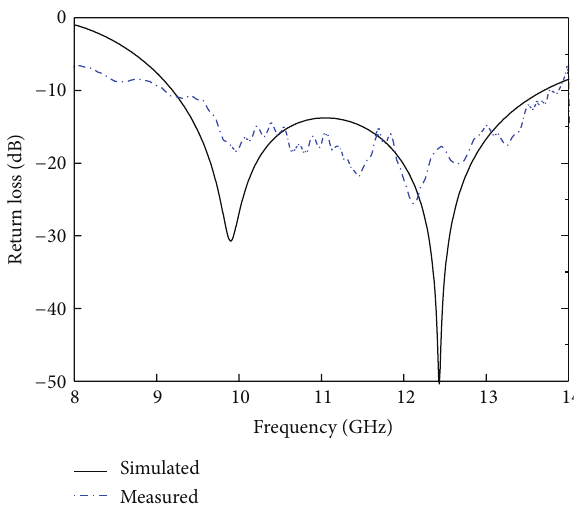
Figure 11: Main polarized levels and cross-polarized levels versus frequency with different slotted cavities.